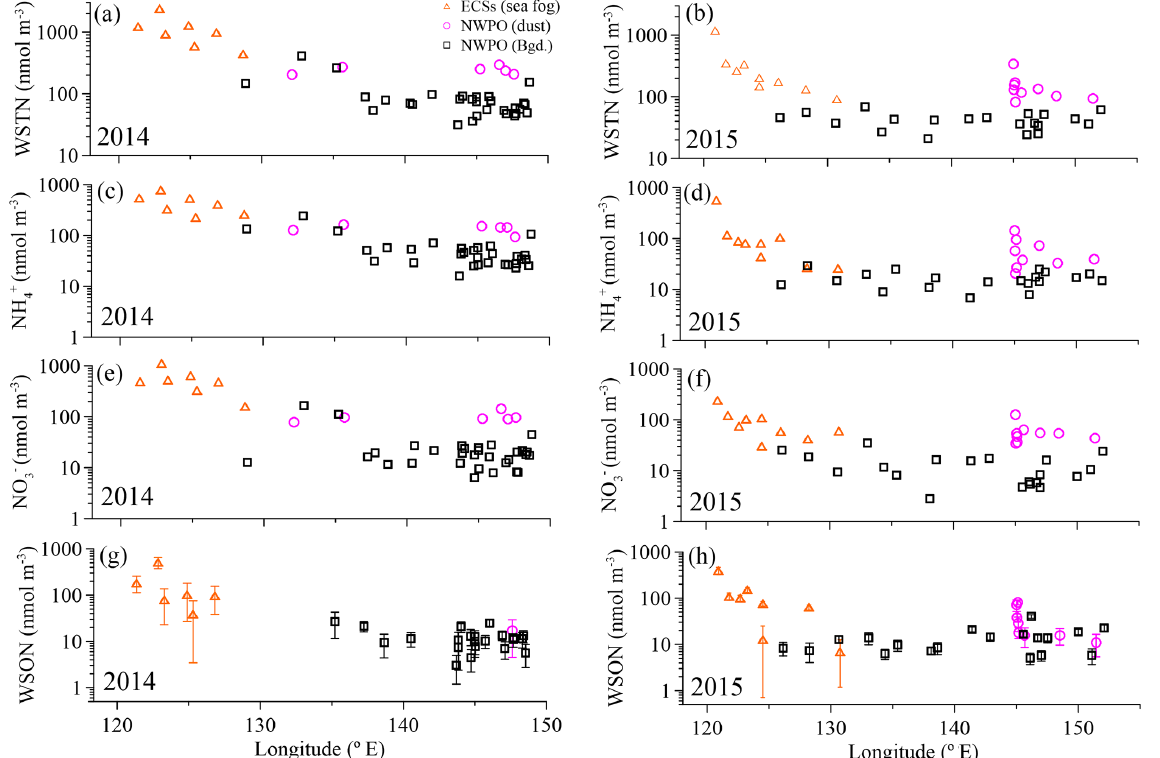
Figure 2. Concentrations of aerosol WSTN ( a, b ), NH + The orange open triangles denote sea-fog-modified aerosol in the ECSs, the pink circles denote dust aerosol, and the black open squares denote background aerosol in the NWPO. The error bars in (g) and (h) were the uncertainties of WSON caused by error propagation during the